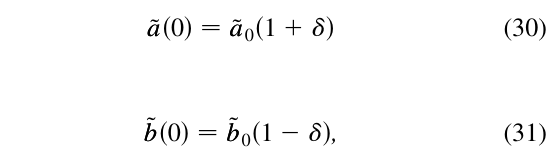
FIG. 4. Plot of the normalized envelope functions ~ aa and ~ bb versus normalized propagating distance s=S for (cid:1) 10 , g (cid:4) (cid:7) 0 : 5 , + (cid:4) 0 : 5 , and ^ RR (cid:4) 4 : 0